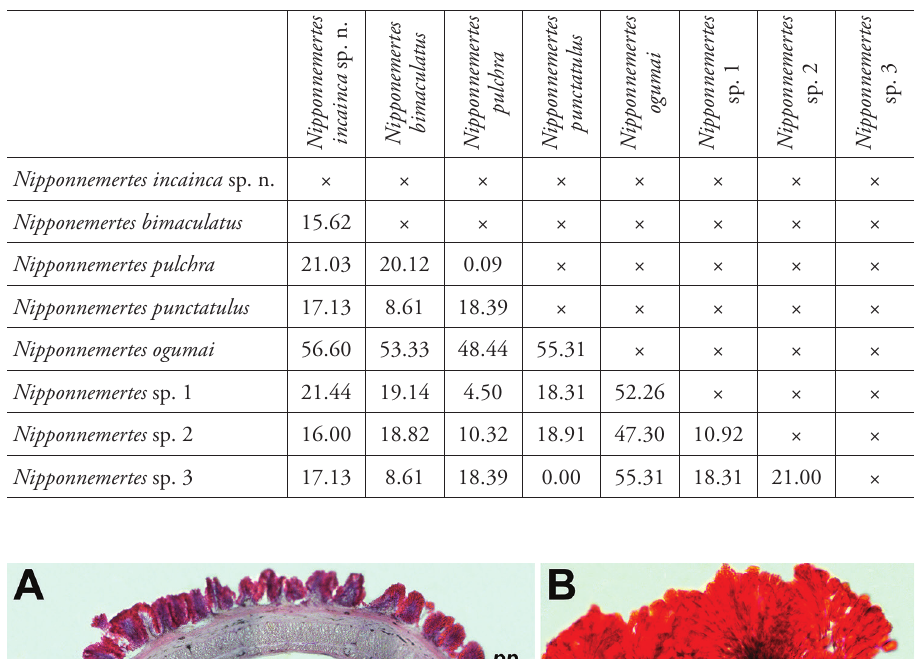
Table 2. COI-based matrix of interspecific and intraspecific genetic distances, using Kimura’s two-param- eter model K2P (Kimura 1980). GenBank accession numbers: Nipponnemertes incainca sp. n. (KX879856); N. bimaculatus (AJ436909); N. pulchra (KP697761–KP697767); N. punctatulus (AJ436910); N. ogumai